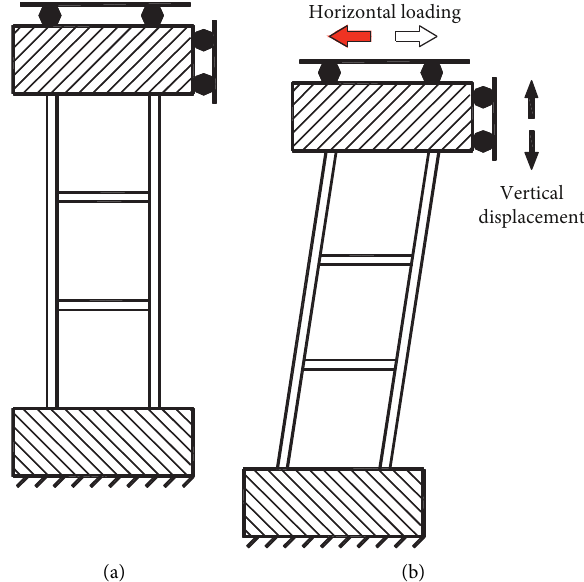
Figure 3: Boundary conditions applied to very short shear link: (a) initial configuration; (b) deformed configuration.